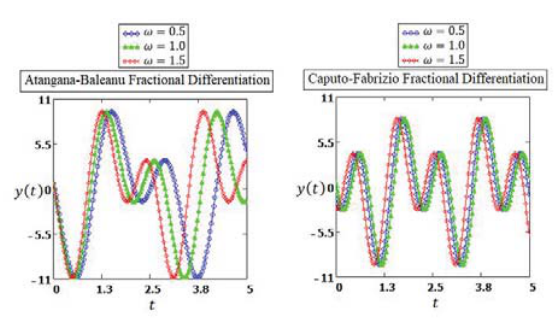
Figure 4: Profile of displacement for varying excitation frequency response curves with parametric values τ 0 = 0.2, F = 0.3, t = 2 s , η 1 = η 2 = 0.7 subject to Atangana-Baleanu and Caputo-Fabrizio fractional differential operators.